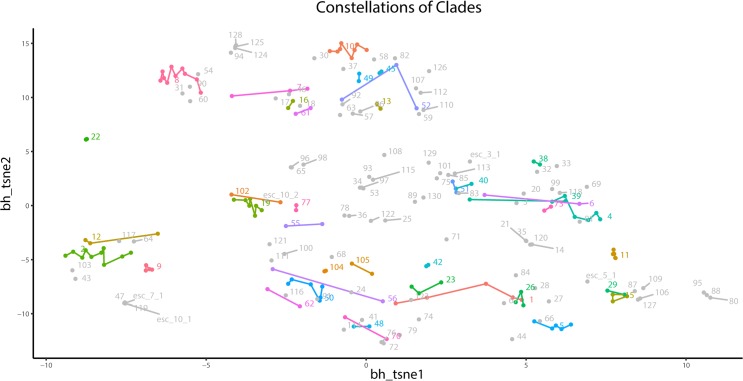
Constellation plot of clades.The constellation plot is designed to visualize both the expression and clade information of discovered subpopulations. Here, the centroids (average expression) of PAC-MAN-discovered subpopulations in the example tissue dataset are projected onto a t-SNE 2D space. Clades that only occur in one sample are colored grey. The non-grey clades occur in at least two samples, with unique colors and clade identification denoting each clade. On the constellation plot, the closest multi-sample clade subpopulations are connected by a straight line.